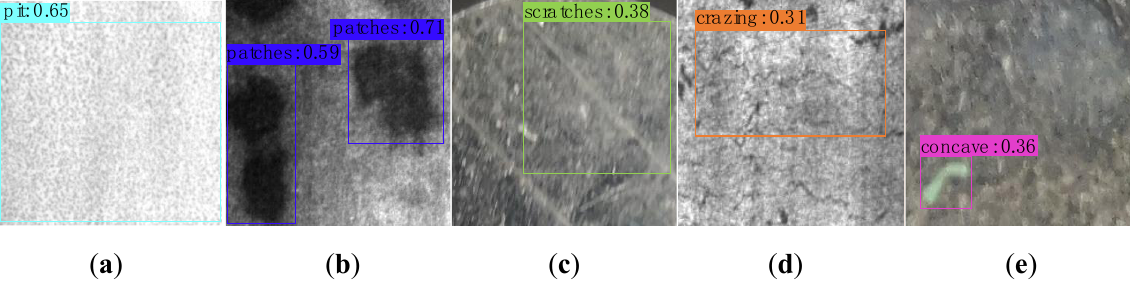
Figure 16. The test results of YOLOv3. ( a ) The defects of pit. ( b ) The defects of patch. ( c ) The defects of scratch. ( d ) The defects of crack . (e) The defects of concave